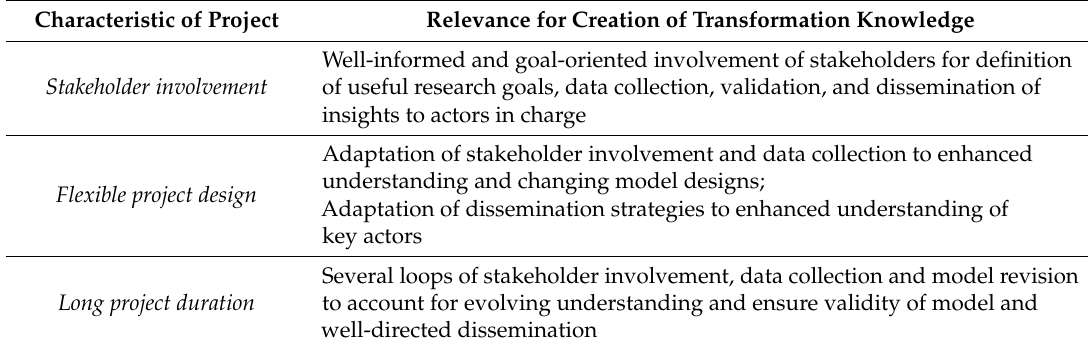
Table 5. Recommendations for the design of projects with the goal to create transformation knowledge. Characteristic of